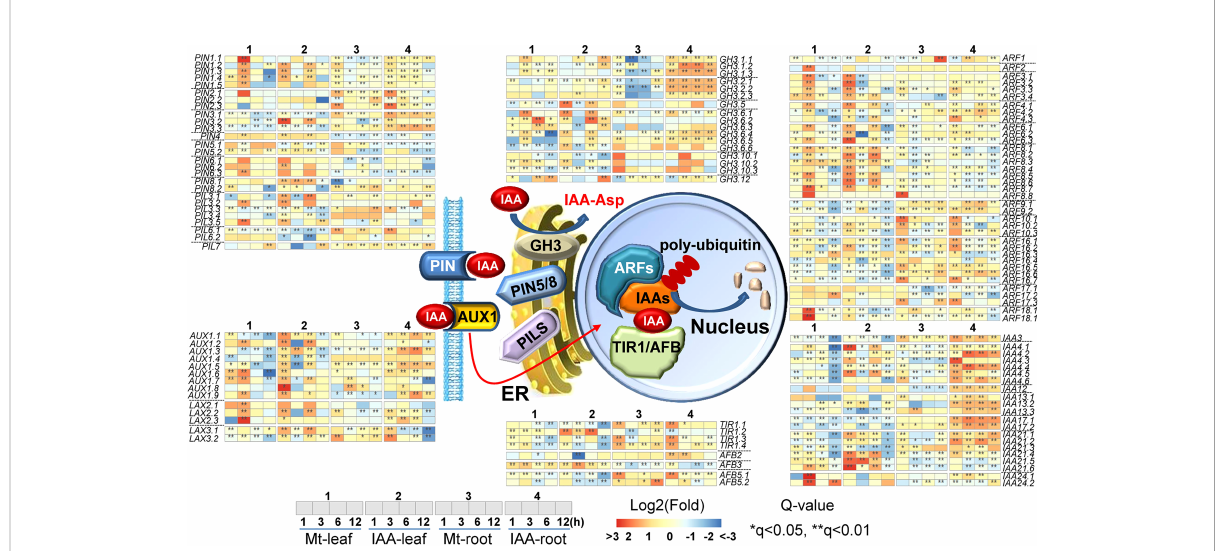
FIGURE 5 Expression changes of genes related to auxin transportation and signaling pathway. The middle part indicates models of IAA transportation and signaling pathway. Non-italics indicate the enzymes/proteins that catalyze the molecular reaction, while italics indicate the genes which may encode the corresponding proteins. Heat-maps indicate expression changes at a time point, while asterisks indicate signi fi cant change, compared to the untreated samples (0 h). Asterisks indicate signi fi cant differences (*q < 0.05 and **q < 0.01) compared to the untreated samples (0